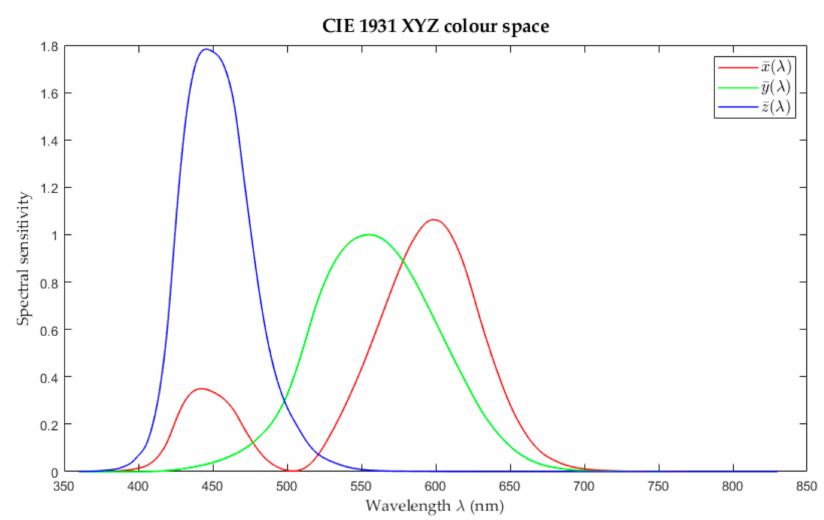
Figure A2. The CIE XYZ standard observer colour matching functions. Adapted from Jeff Mather (2021). Spectral and XYZ Color Functions (https://www.mathworks.com/matlabcentral/ fileexchange/7021-spectral-and-xyz-color-functions. Accessed on 15 January 2021) MATLAB Central Exchange Retrieved 5 January